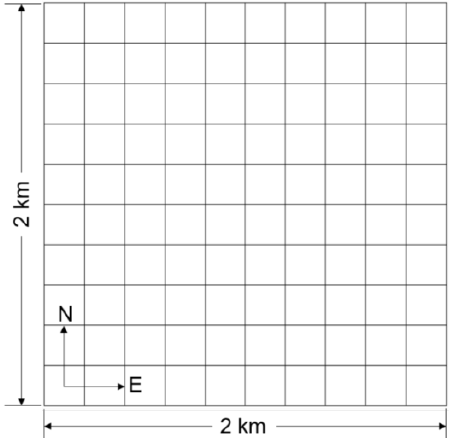
Figure 3. Wind farm grid for the layout optimization. Table 1. Properties of Wind Turbines and Wind Farm.